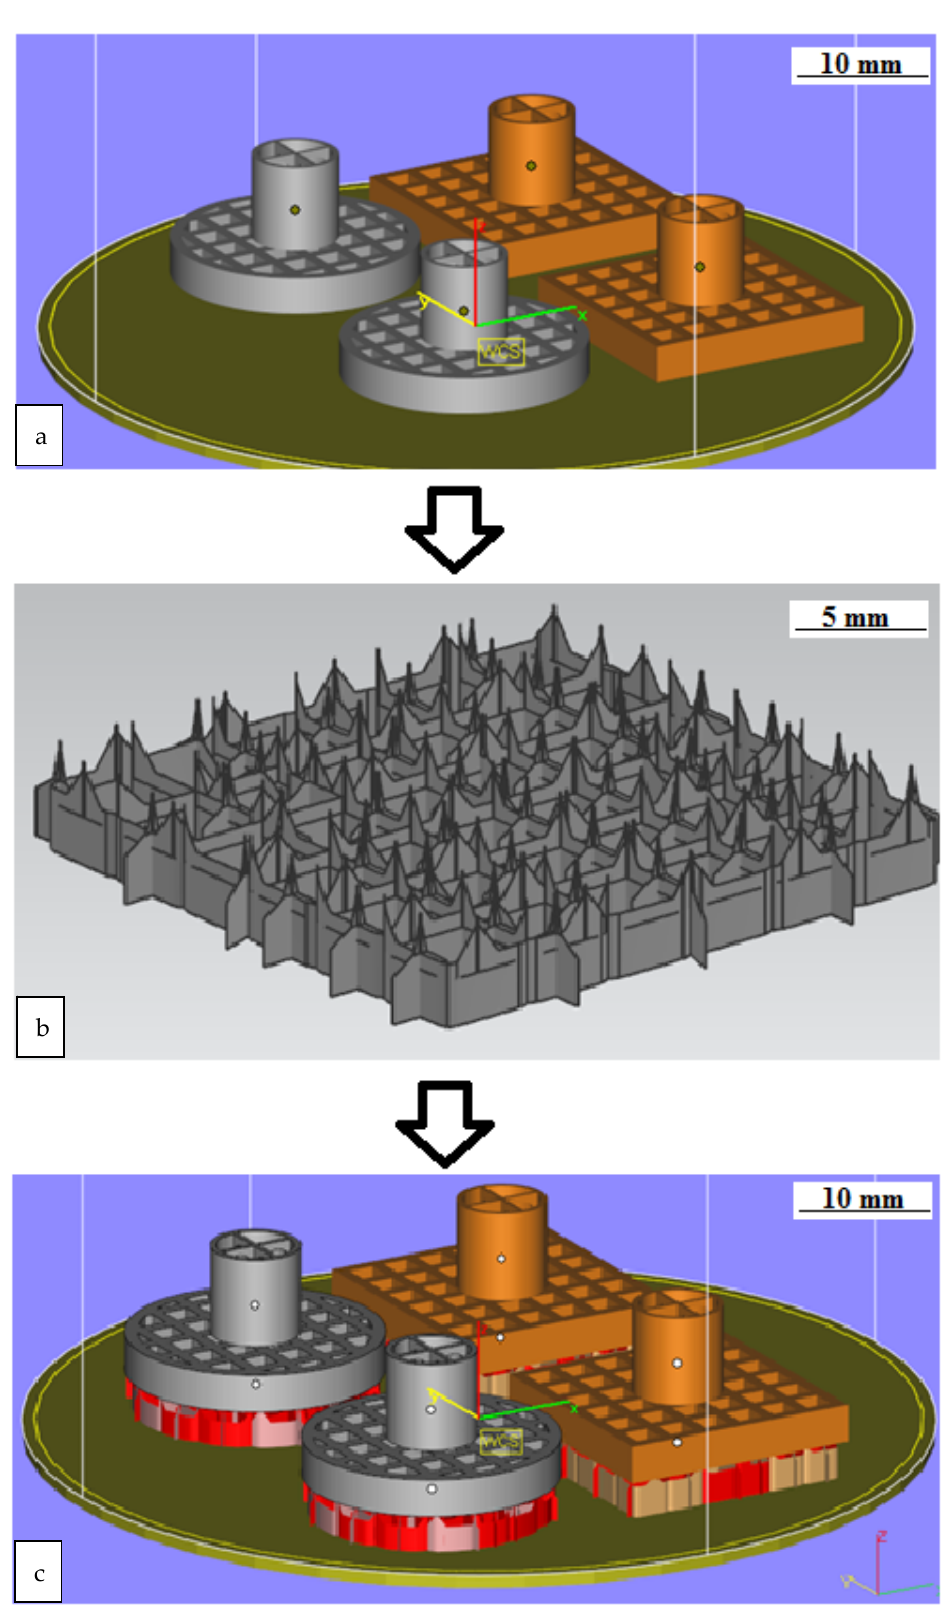
Figure 5. ETmodeling: ( a ) Materialize Magics workspace with placement of models for manufactur- ing; ( b ) supports for square ET; ( c ) arrangement of models on supports in the working space of the